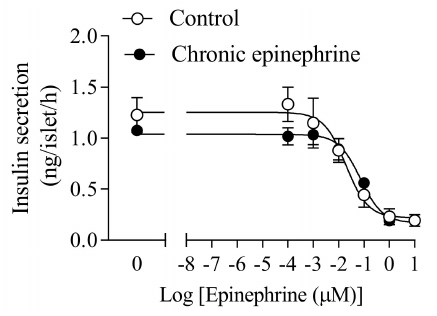
Figure 4. Effective epinephrine concentration to inhibit insulin secretion responsiveness in the islets. The epinephrine dose response was determined under stimulatory conditions of 20 mM glucose.